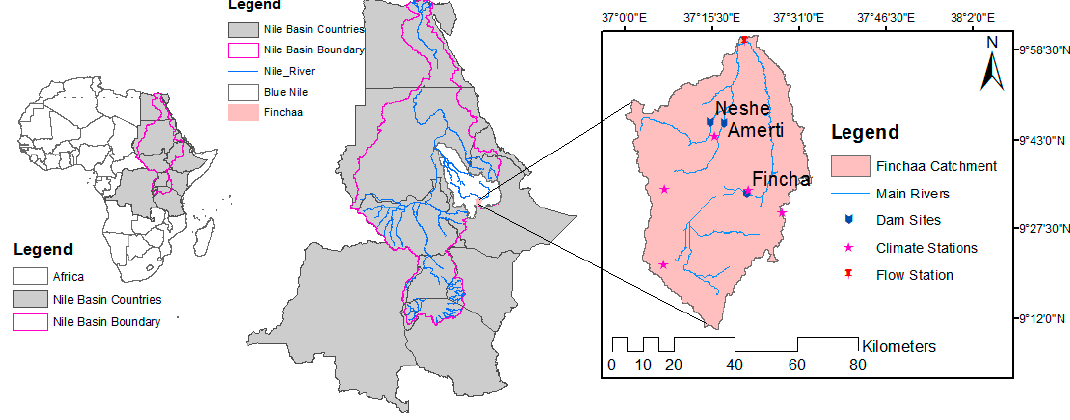
Figure 1. Map of the study areas.